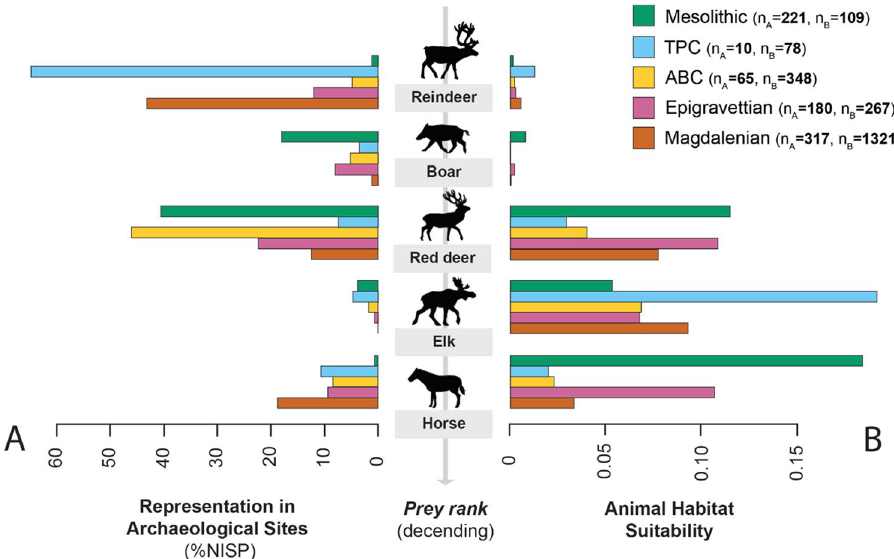
Figure 2. Comparison of zooarchaeological NISP proportions and climate-inferred habitat suitability for the top-ranked prey species. ( A ) presents the averaged zooarchaeological assemblage compositions attributable to each species for each CTU. ( B ) shows the reconstructed average habitat suitability for each species of each CTU. Each bar represents the zooarchaeological abundance ( A ) and the habitat suitability ( B ) for the corresponding top-ranked prey species colored by CTU affiliation. Note that these bars are not directly comparable between species. In comparing ( A ) and ( B ), it is evident that LUP foragers were not targeting species based on which species are most abundant, but on the species’ prey rank, with a preference for higher-ranked prey